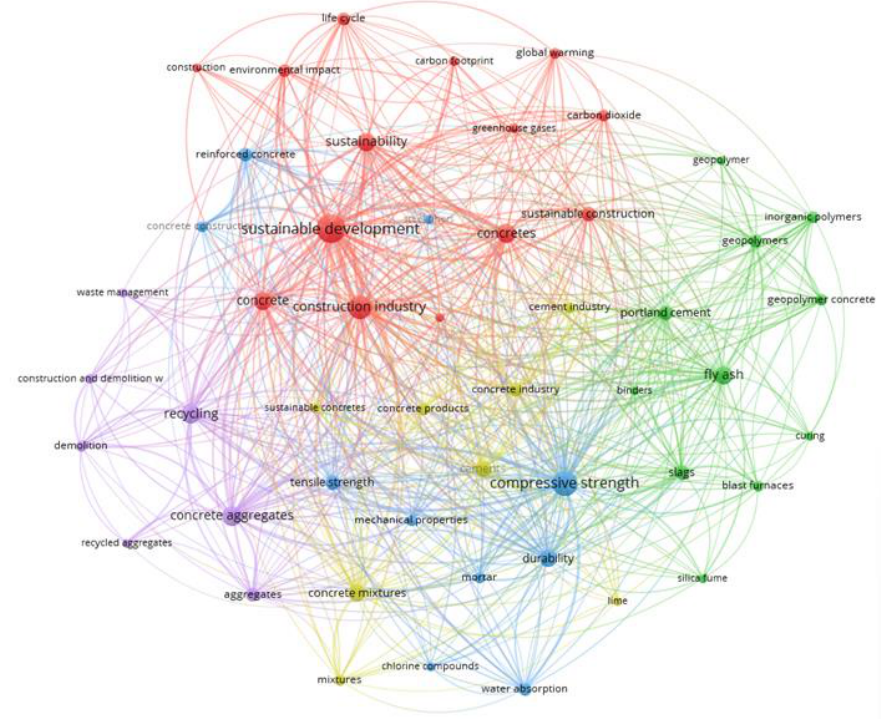
Figure 2. Correlation between selected sustainable development goals and development pathways in construction (based on VOSviewer, 26 November 2022).